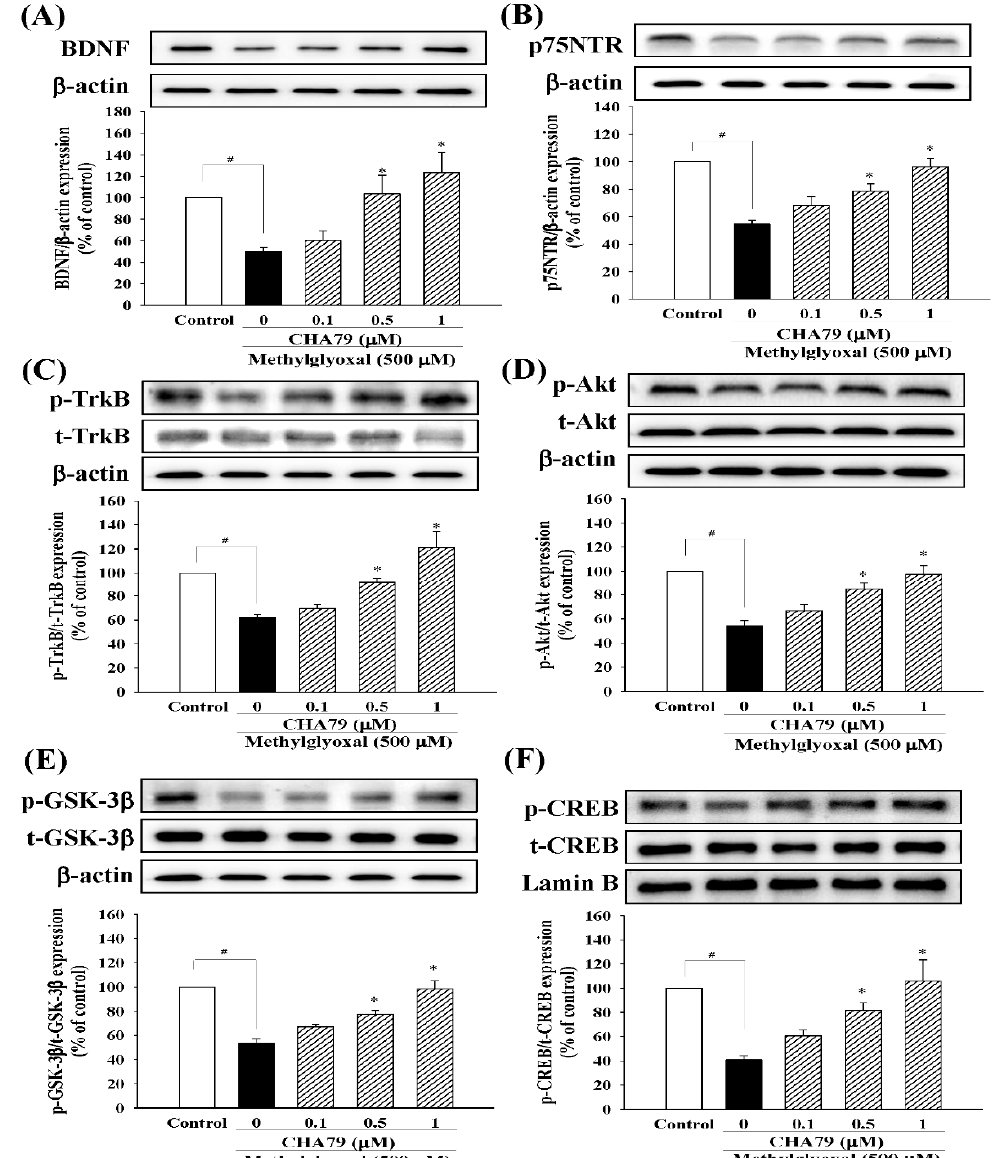
Figure 5. CHA79 up-regulated BDNF ( A ), p75NTR ( B ), p-TrkB ( C ), p-Akt ( D ), p-GSK-3 β ( E ), and p- CREM ( F ) expression in MG-treated SH-SY5Y dopaminergic neurons. One-hour pre-treatment